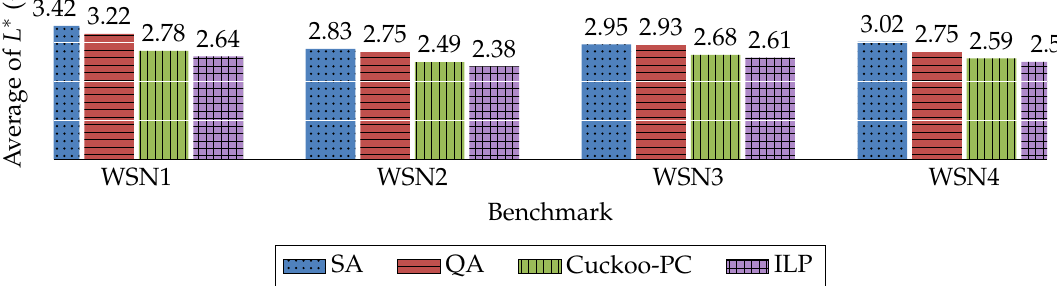
Figure 5. The average amount of L ∗ for each node ( γ ). (The average value over 30 runs of the